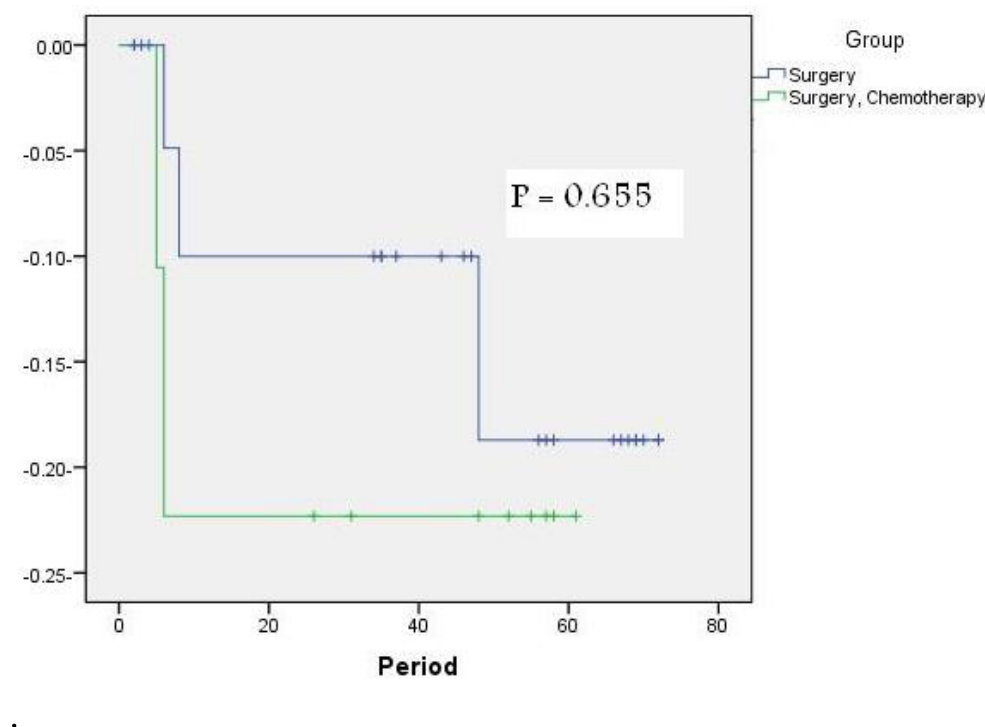
Figure 3. Complete resection with insignificant P